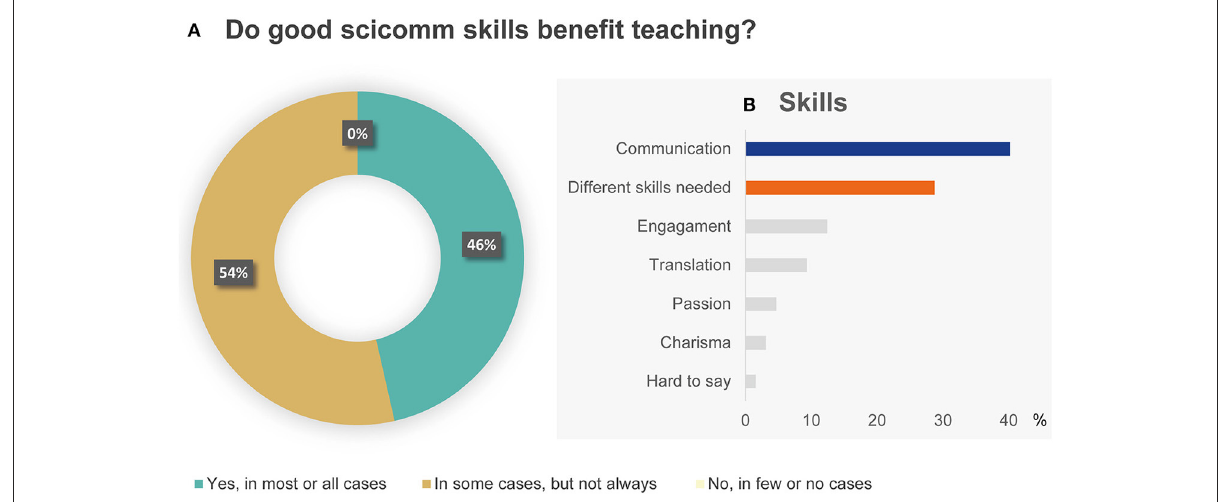
FIGURE5 How do scicomm skills benefit teaching in the palaeosciences? Respondents could choose between three multiple-choice options (indicated in mustard, green, and beige) for part (A) , but could list multiple skills in free text for part (B)